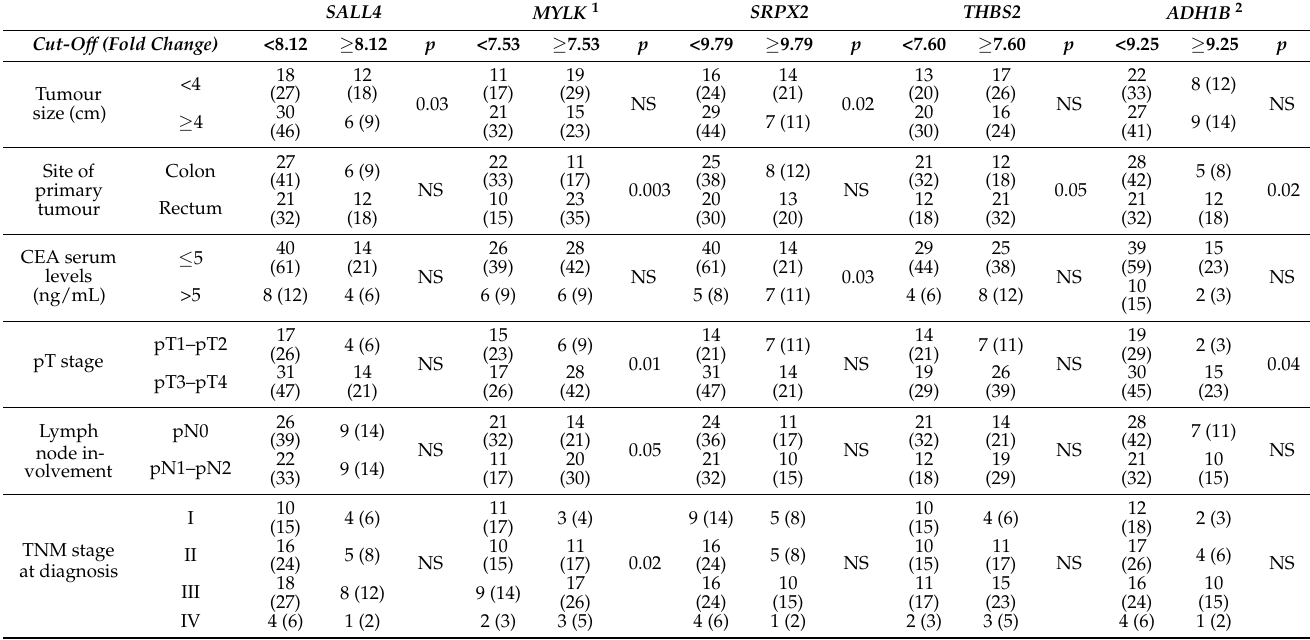
Table 3. Association between clinical–biological and histopathological characteristics of sCRC patients (n = 66) and the most strongly dysregulated transcripts with any significant association. SALL4